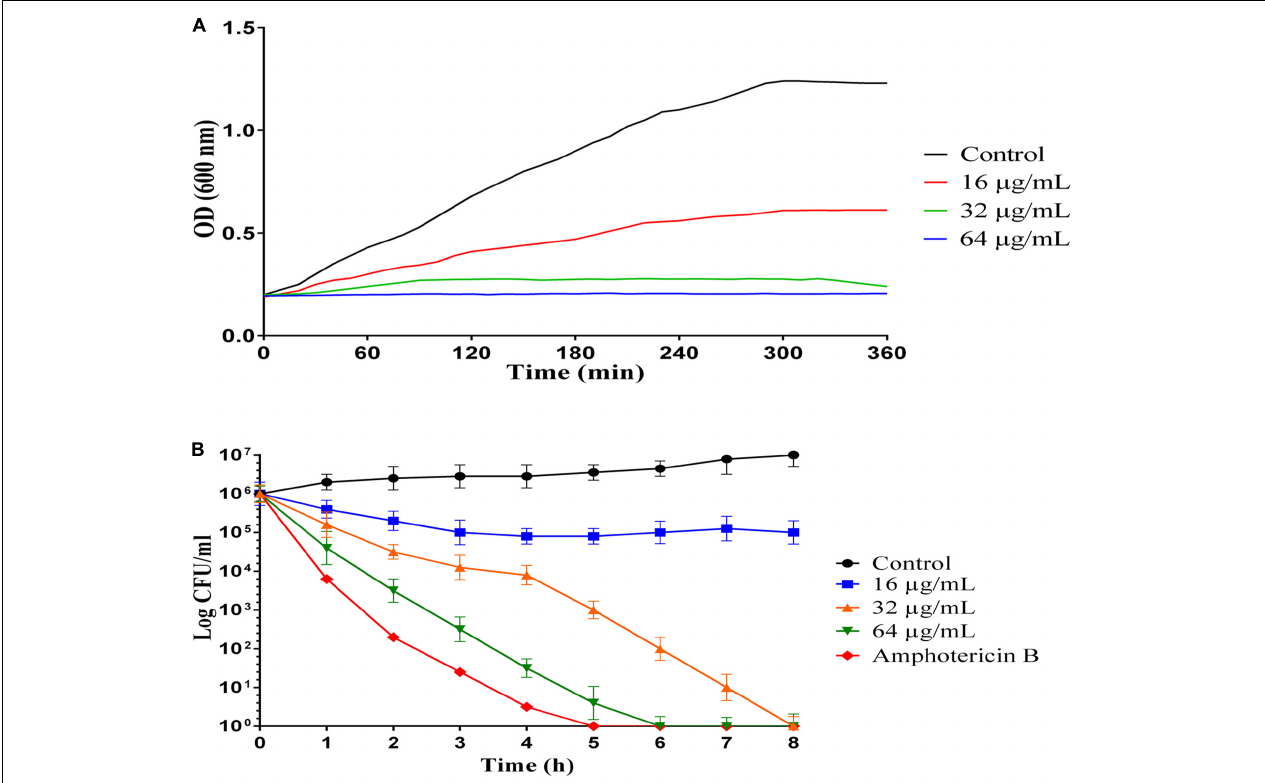
FIGURE 1 | Inhibition and killing kinetics of MCh-AMP1 against C. albicans . (A) Optical density measurements at 600 nm of exponentially growing C. albicans , with and without peptide at 16–64 µ g/mL concentrations. (B) Time-killing kinetics of MCh-AMP1 against C. albicans ATCC 10231. C. albicans cells (1 × 10 6 cells/mL) suspensions were treated with different concentrations of MCh-AMP1 (16–64 µ g/mL). Each data point represents mean ± SD of three separate experiments in triplicate sets